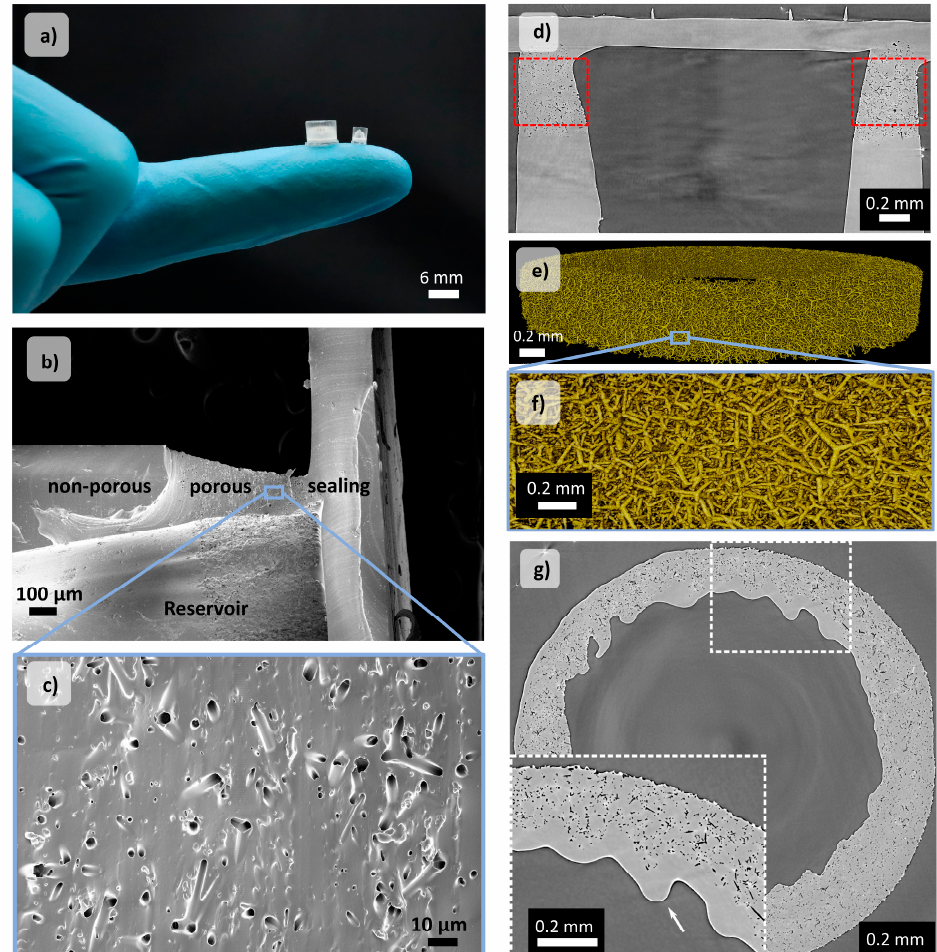
Figure 3. ( a ) Photograph of reservoir-based drug delivery system (rDDS) of different sizes. ( b ) Scan- ning electron microscopy (SEM) image of the rDDS, showing the non-porous and porous parts of the membrane and the sealing. ( c ) SEM image of the porous membrane. ( d ) Slice from the SRµCT imaging of the rDDS in the yz plane. The red area indicates the sample fraction used for analysis. ( e ) The 3D rendering of the segmented microchannel network and ( f ) zoom into the microchannel network. ( g ) Slice from the SRµCT imaging of the rDDS in the xy plane. The inset shows a zoom into a region where some of the microchannel-reservoir interface has been blocked by PDMS (white arrow).